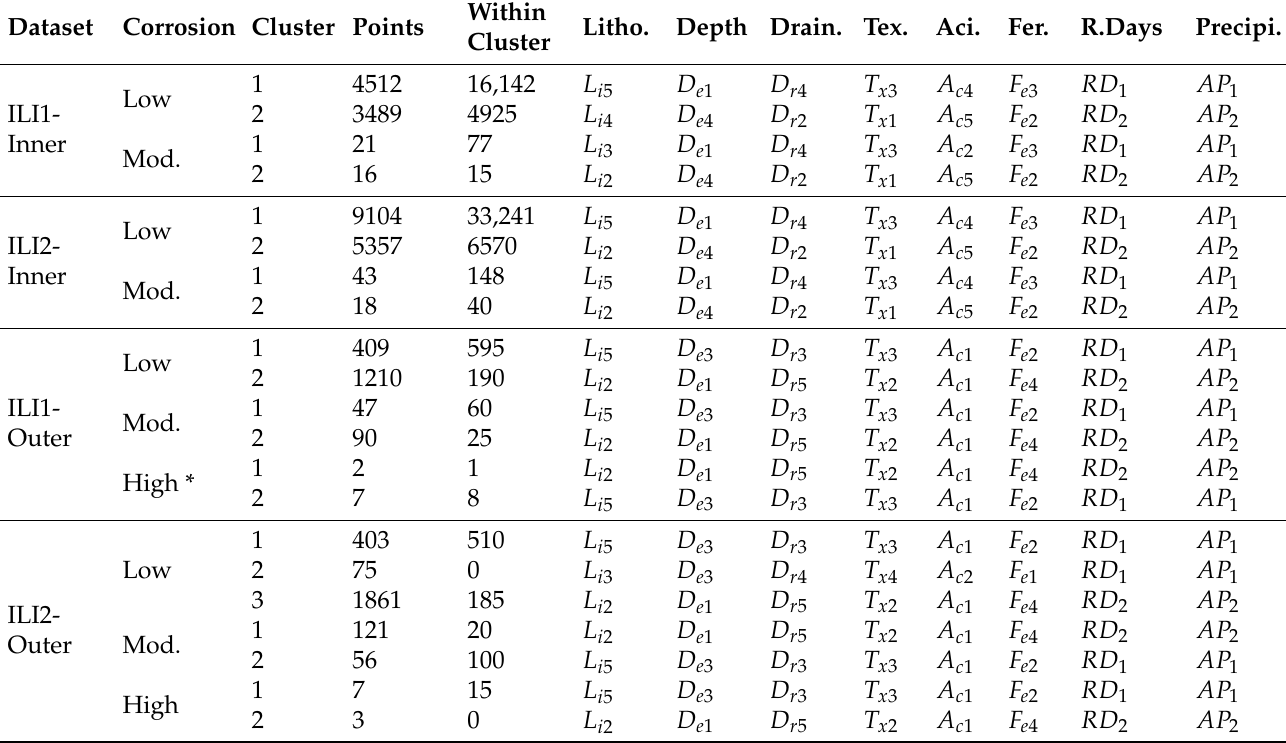
Table 7. K -mode clusters per dataset and corrosion